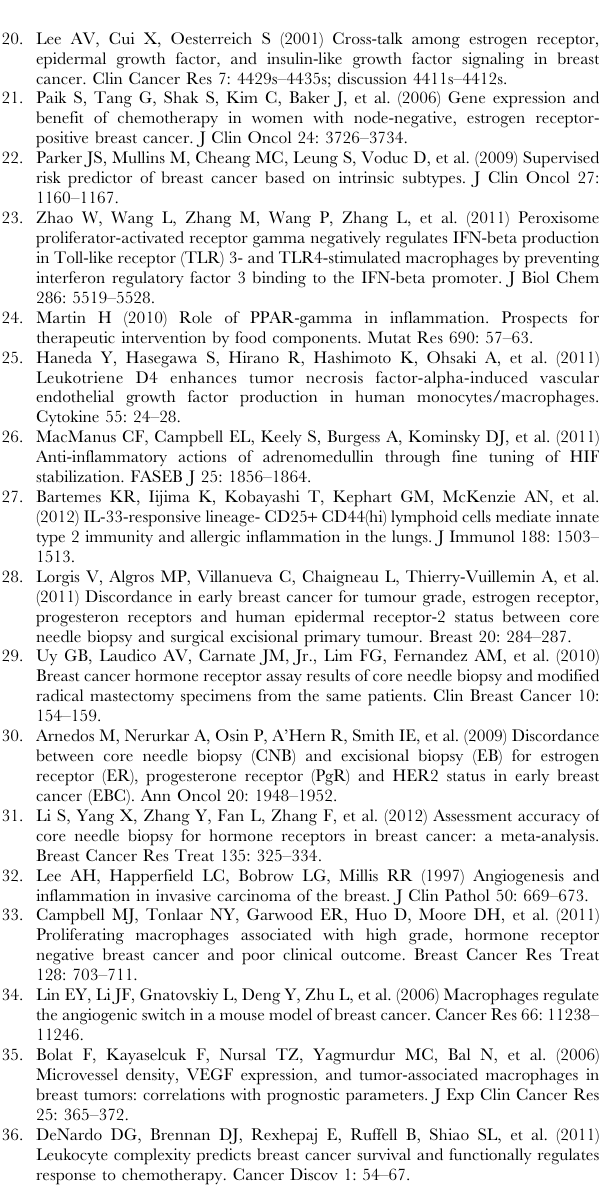
Table S1 Nanostring gene expression analysis. Normal- ized nanostring gene expression values for the 147 transcripts. Table S2 Gene expression differences between CNB and EB. The table includes the mean, median and standard of change between the biopsies and the p-values for the Wilcoxon’s signed rank test. Table S3 The increase in immune responsive gene expression at the time of the EB is not dependent on the time interval between the CNB and EB. Wilcoxon’s rank sum tests were performed to evaluate the association of the